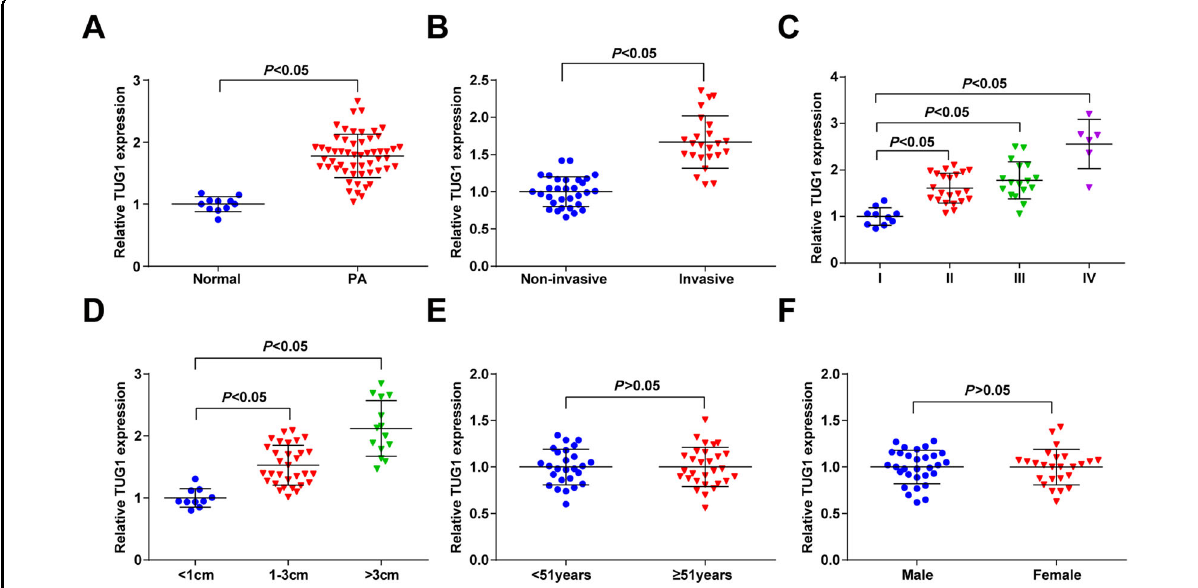
Fig. 1 Expression of TUG1 in PA and its correlation with tumorigenesis. A TUG1 expression in PA tissues was detected using RT-qPCR; B TUG1 expression in invasive and non-invasive PA tissues was detected using RT-qPCR; C TUG1 expression in PA tissues with different knosp grades was detected using RT-qPCR; D, TUG1 expression in PA tissues with different tumor sizes was detected using RT-qPCR E, TUG1 expression in PA tissues from PA patients with different ages was detected using RT-qPCR; F, TUG1 expression in PA tissues from PA patients with different genders was detected using RT-qPCR; n = 11 in the normal group and n = 55 in the PA group. Data are presented as mean ±